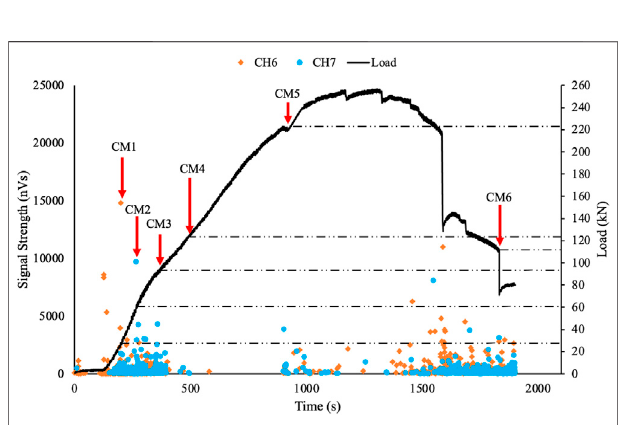
FIGURE 8 | Signal strength distribution and load for Beam S2B.